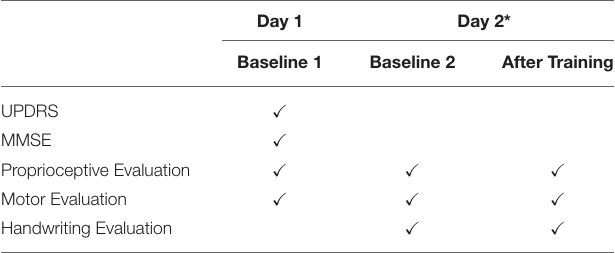
TABLE 2 | List and evaluation time points of outcome